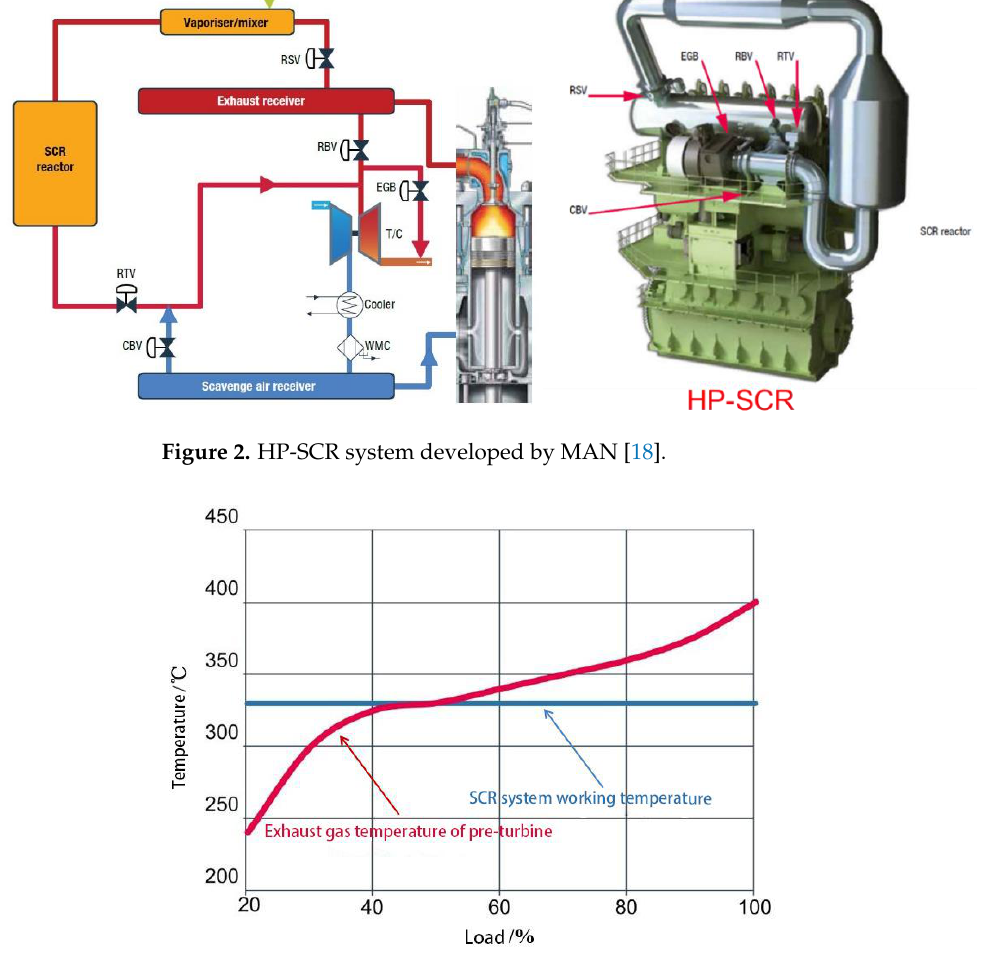
Figure 3. The relationship between the exhaust gas temperature before the turbine and the minimum operating temperature required by the SCR system [18].